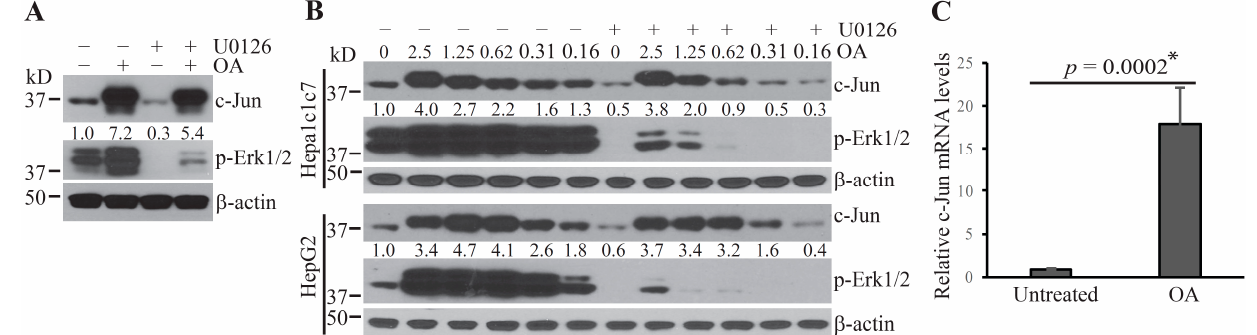
Figure 1. Protein phosphatase inhibition increases the levels of c-Jun protein. ( A ) Hepa1c1c7 cells were pretreated with or without 2.5 µ M okadaic acid (OA) for 30 min and then incubated with or without 10 µ M U0126 for 1 h. ( B ) Hepa1c1c7 and HepG2 Cells were pretreated with serially diluted concentrations of OA as indicated for 30 min and then treated with or without U0126 for 1 h. Cells were extracted with NuPAGE lithium dodecyl sulfate (LDS) sample buffer following the treatment. Protein levels of c-Jun, p-Erk1/2, and β -actin in the cell lysates were assessed by Western blotting. Band intensities of c-Jun were quantified and normalized using β -actin levels. The normalized amounts are shown under each band. Data shown are representative of at least two independent experiments. ( C ) Hepa1c1c7 cells were treated with 2.5 µ M OA for 1.5 h. c-Jun mRNA levels were measured by qPCR and normalized using levels of Gapdh . Data shown were generated from three sets of independently prepared samples assessed by qPCR twice. Data were statistically analyzed using an unpaired, two-tailed Student’s t -test, and significant difference * was determined to be p < 0.01.